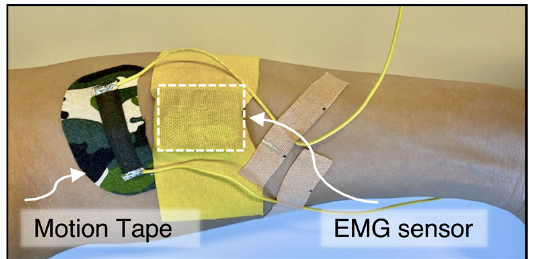
Figure 6. Motion Tape and an sEMG sensor were worn on a subject’s forearm while bicep curls were performed.